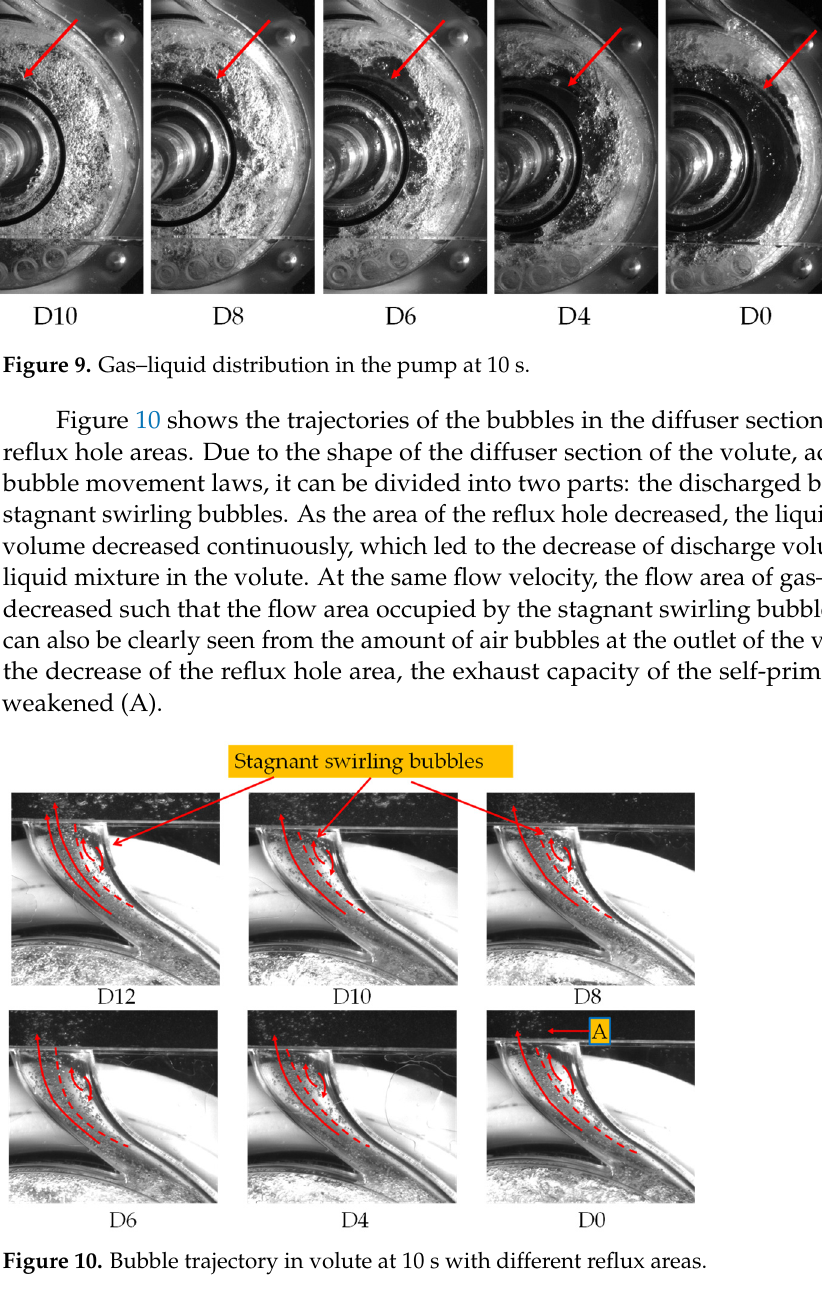
Figure 11. Bubble tracking at the volute diffuser. ( a ) 9.587 s, ( b ) 9.587 s + Δ t, ( c ) 9.587 s + 2 Δ t, ( d ) 9.587 s + 3 Δ t, ( e ) 9.587 s + 4 Δ t, and ( f ) 9.587 s + 5 Δ t. 4. Conclusions In order to deeply reveal the self-priming mechanism of the self-priming pump, on the premise of ensuring that the self-priming mechanism is consistent, a visual self-